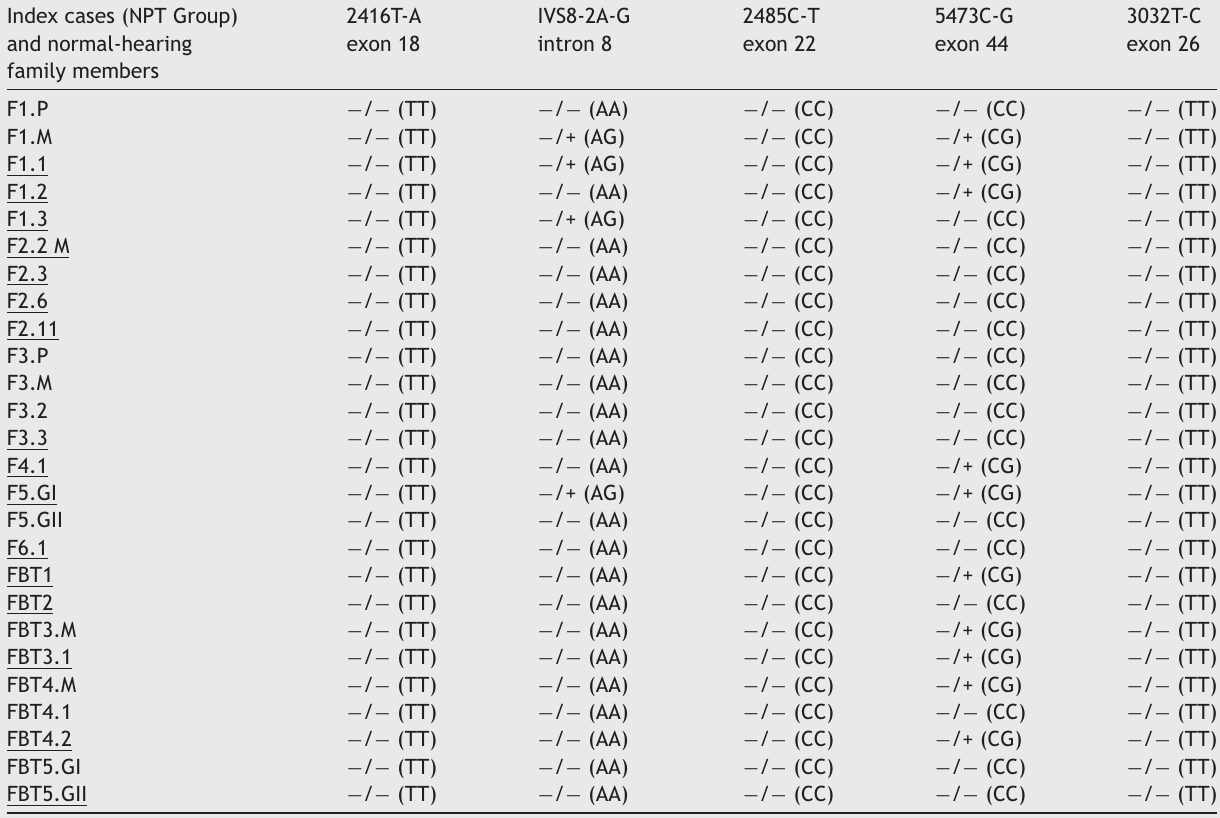
Genotypes found in the NPT group index cases among the five mutations assessed in the OTOF gene.